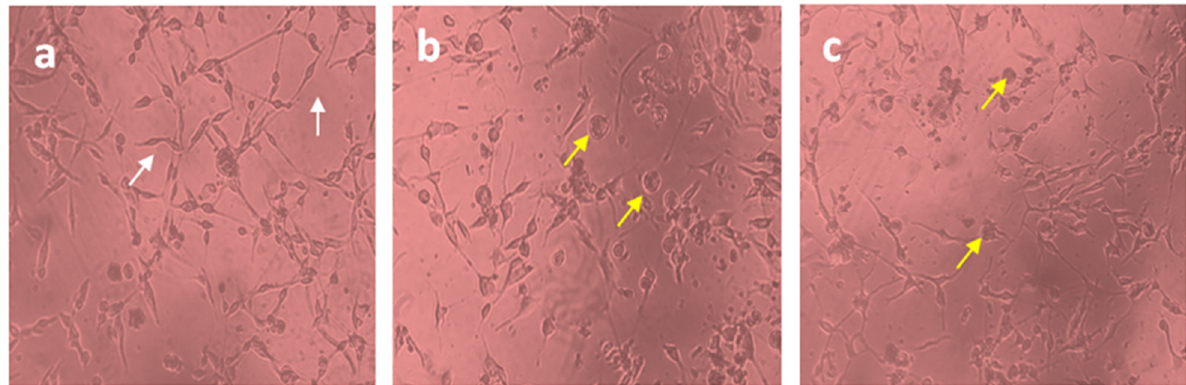
Figure 7. Cell morphology of U87-MG cells (10X). ( a ) Untreated U87-MG cells showed normal cellular structure (white